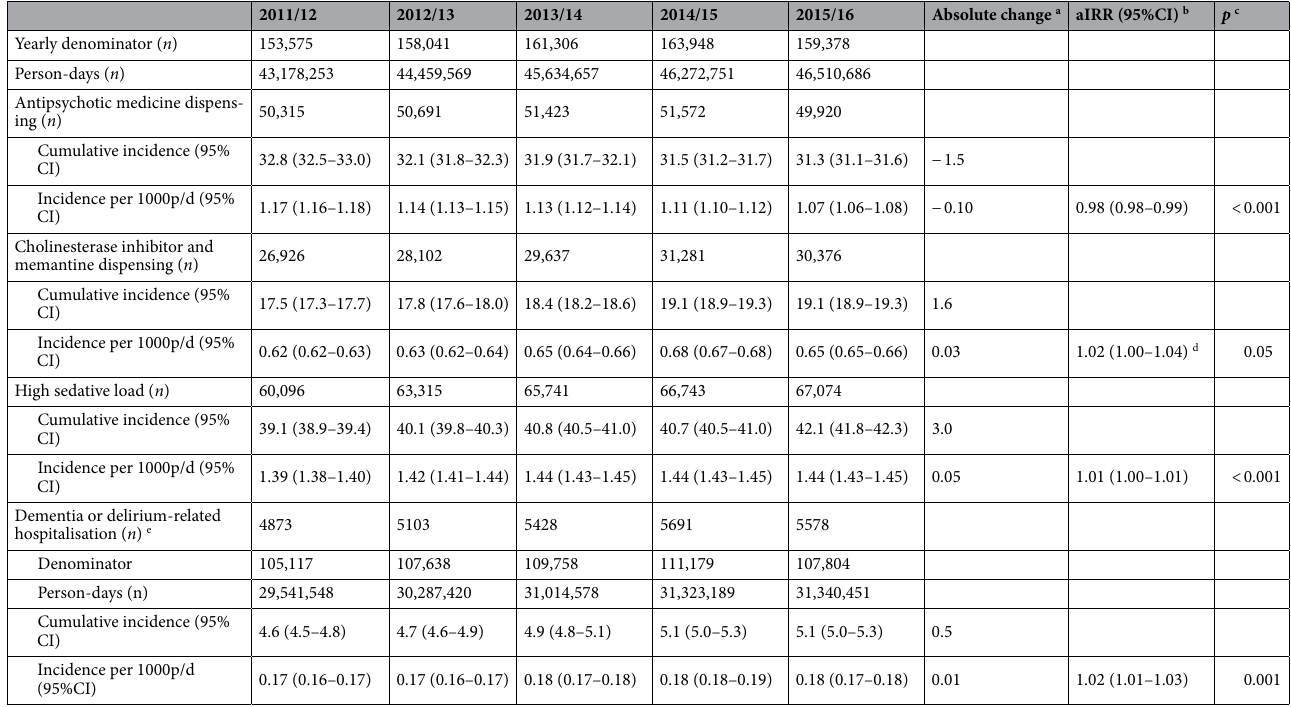
Table 2. Incidence rate and trends in yearly clinical quality indicator performance. aIRR Adjusted incidence rate ratio, CI Confidence interval; p/d Person-days. a From 2011/2012 to 2015/2016—crude difference only. b Annual change adjusted for age (at beginning of each year) and sex. c Bonferroni correction applied. d Adjusted for age (at beginning of each year), sex, and time since cohort entry. e New South Wales, Victoria, and South Australia only.